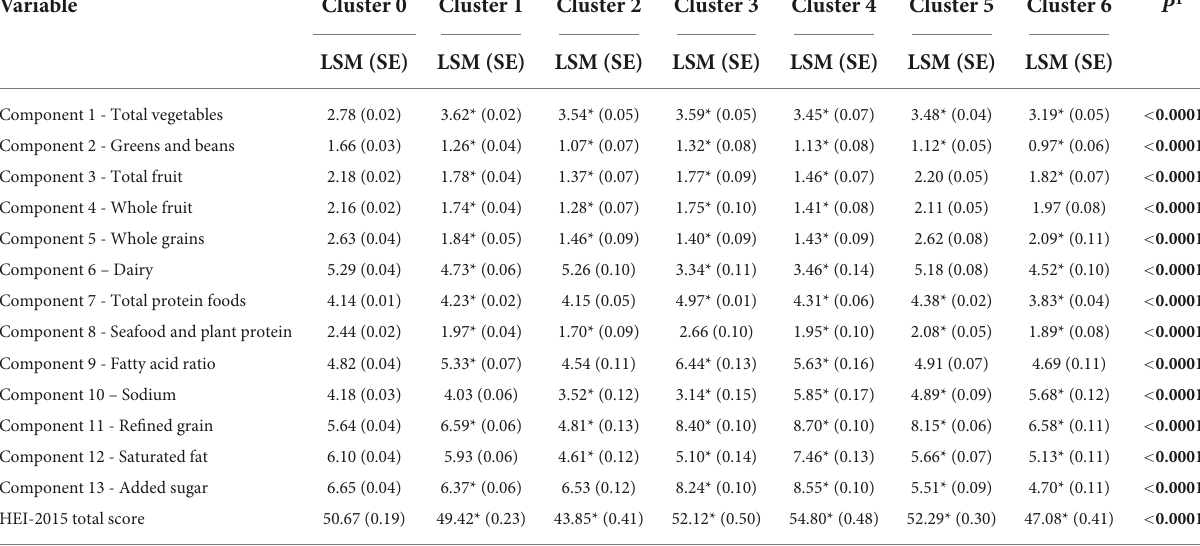
TABLE 4 Least square mean total and subcomponent Healthy Eating Index (2015) scores by potato cluster in American